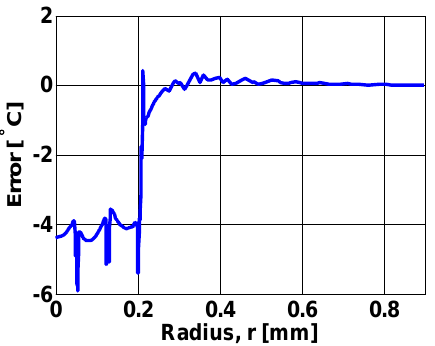
Figure 7. Error in the model in comparison with the FEM simulation.